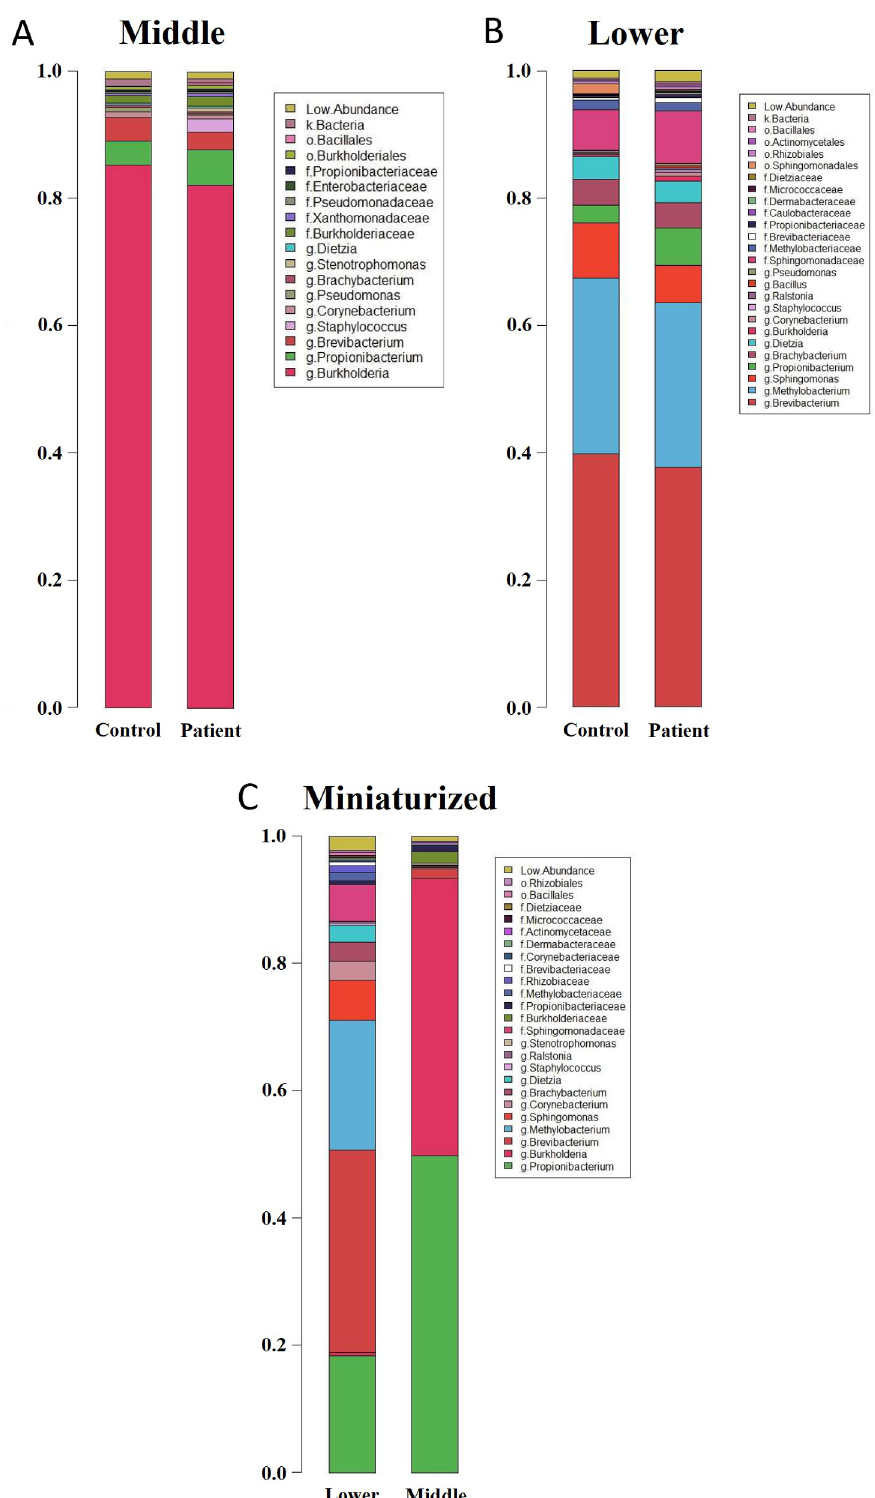
Fig 3. Taxonomic relative abundance across samples. Stacked barplot depicting mean relative abundances in patient and control samples obtained from (A) the middle portion and (B) lower portion of non-miniaturized samples. (C) Relative abundance of lower and middle portions from miniaturized patient vertex samples. Relative abundances are presented in the respective taxonomic ranks–g: Genera; f: Family; o: Order; k: Kingdom. https://doi.org/10.1371/journal.pone.0216330.g003 PLOS ONE | https://doi.org/10.1371/journal.pone.0216330 May 3,